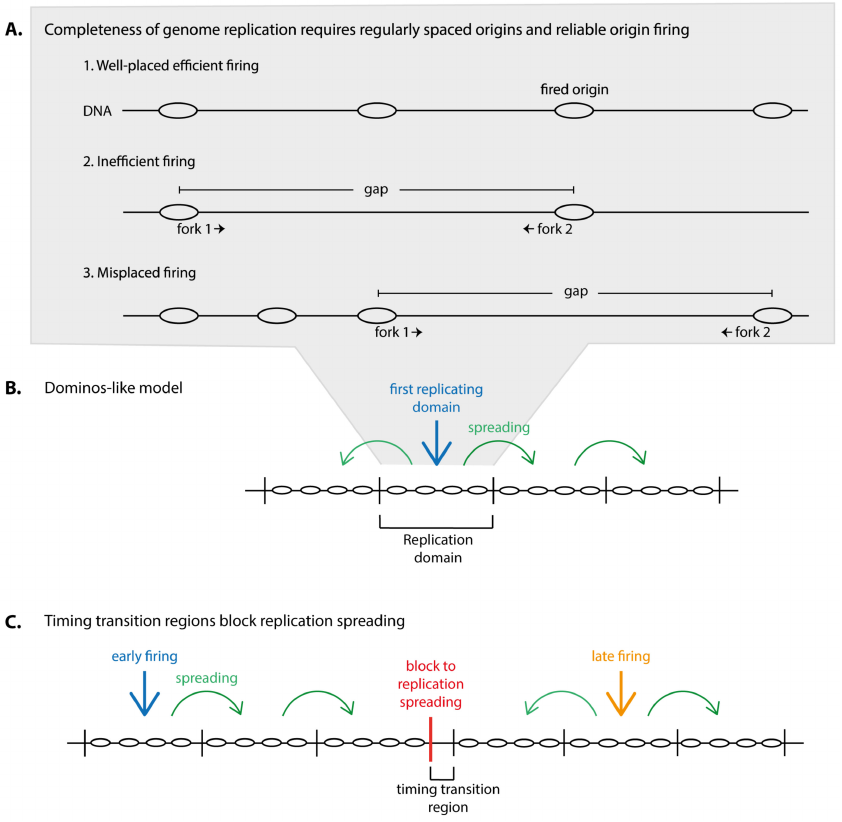
Figure 1. Proper control of origin firing is required for complete genome duplication. ( A ) Well-placed origins and efficient firing are required for complete DNA replication (1.) Replication problems can arise if not enough origins fire (2.) or if origins are misplaced (3.) Such misregulations can result in gaps in the replicating genome that are too big to be replicated by two forks during an S-phase. ( B , C ) Schematic representation of the dominos-like model in which replication spreads from the first replicating domain to its neighbours. This replication spreading is blocked at timing transition regions ( C ). Timing of the later domain at timing transition regions (TTRs) requires a new timing